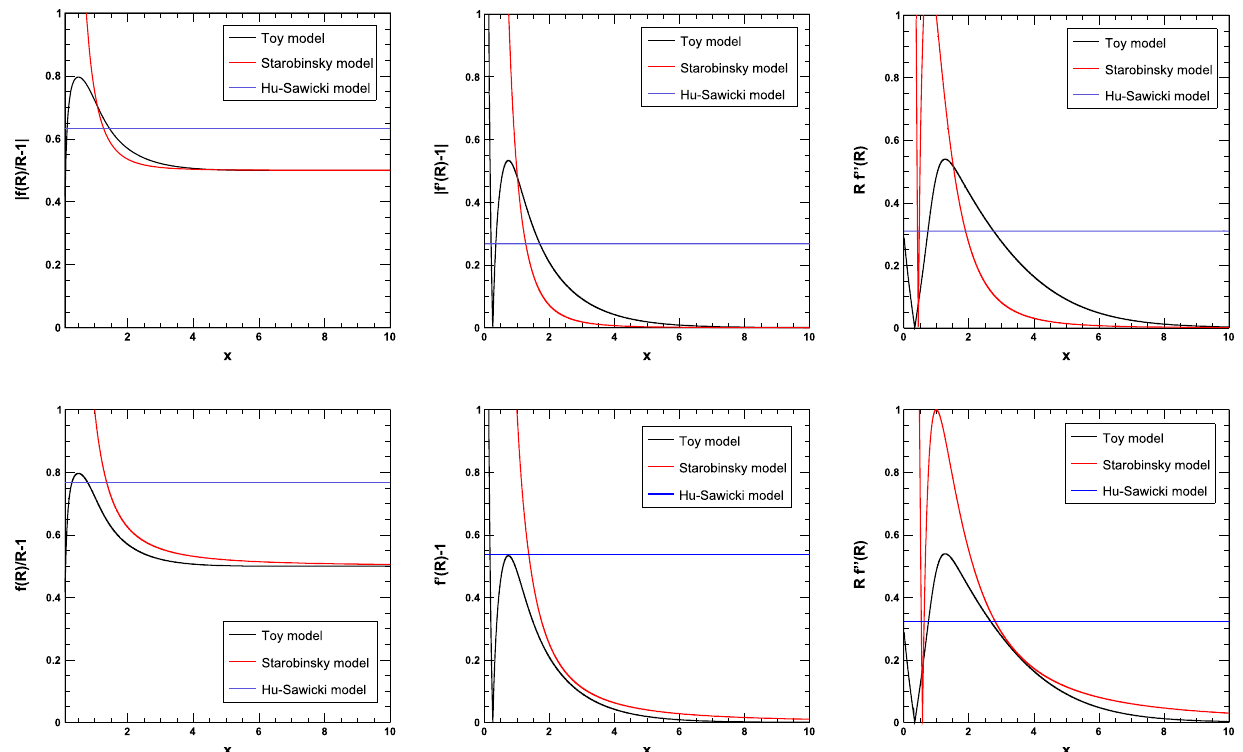
Fig. 13 Solar system test functions with respect to x for the toy model (with α = 0 . 3), Starobinsky model (with n = 2 at the upper panel and n = 1 at the lower panel) and Hu–Sawicki model (with μ = 1 and c 1 = 1 . 5 at the upper panel and c 1 = 1 . 1 at the lower panel)